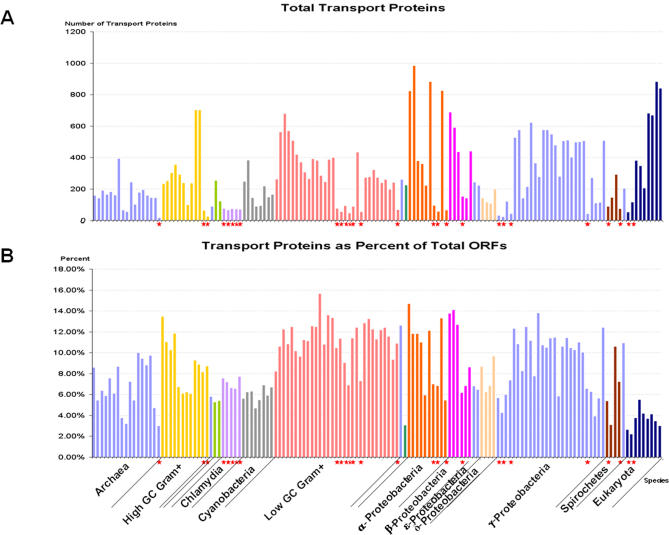
Numbers of Recognized Transport Proteins and Percentage of Total ORFsThe overall numbers of recognized transport proteins (A) and percentage of total ORFs encoding transport proteins (B) were compared for the 141 organisms analyzed. Species from distinct phylogenetic groups are labeled with different colors. The prokaryotic and eukaryotic obligate intracellular parasites/pathogens are marked with red stars.